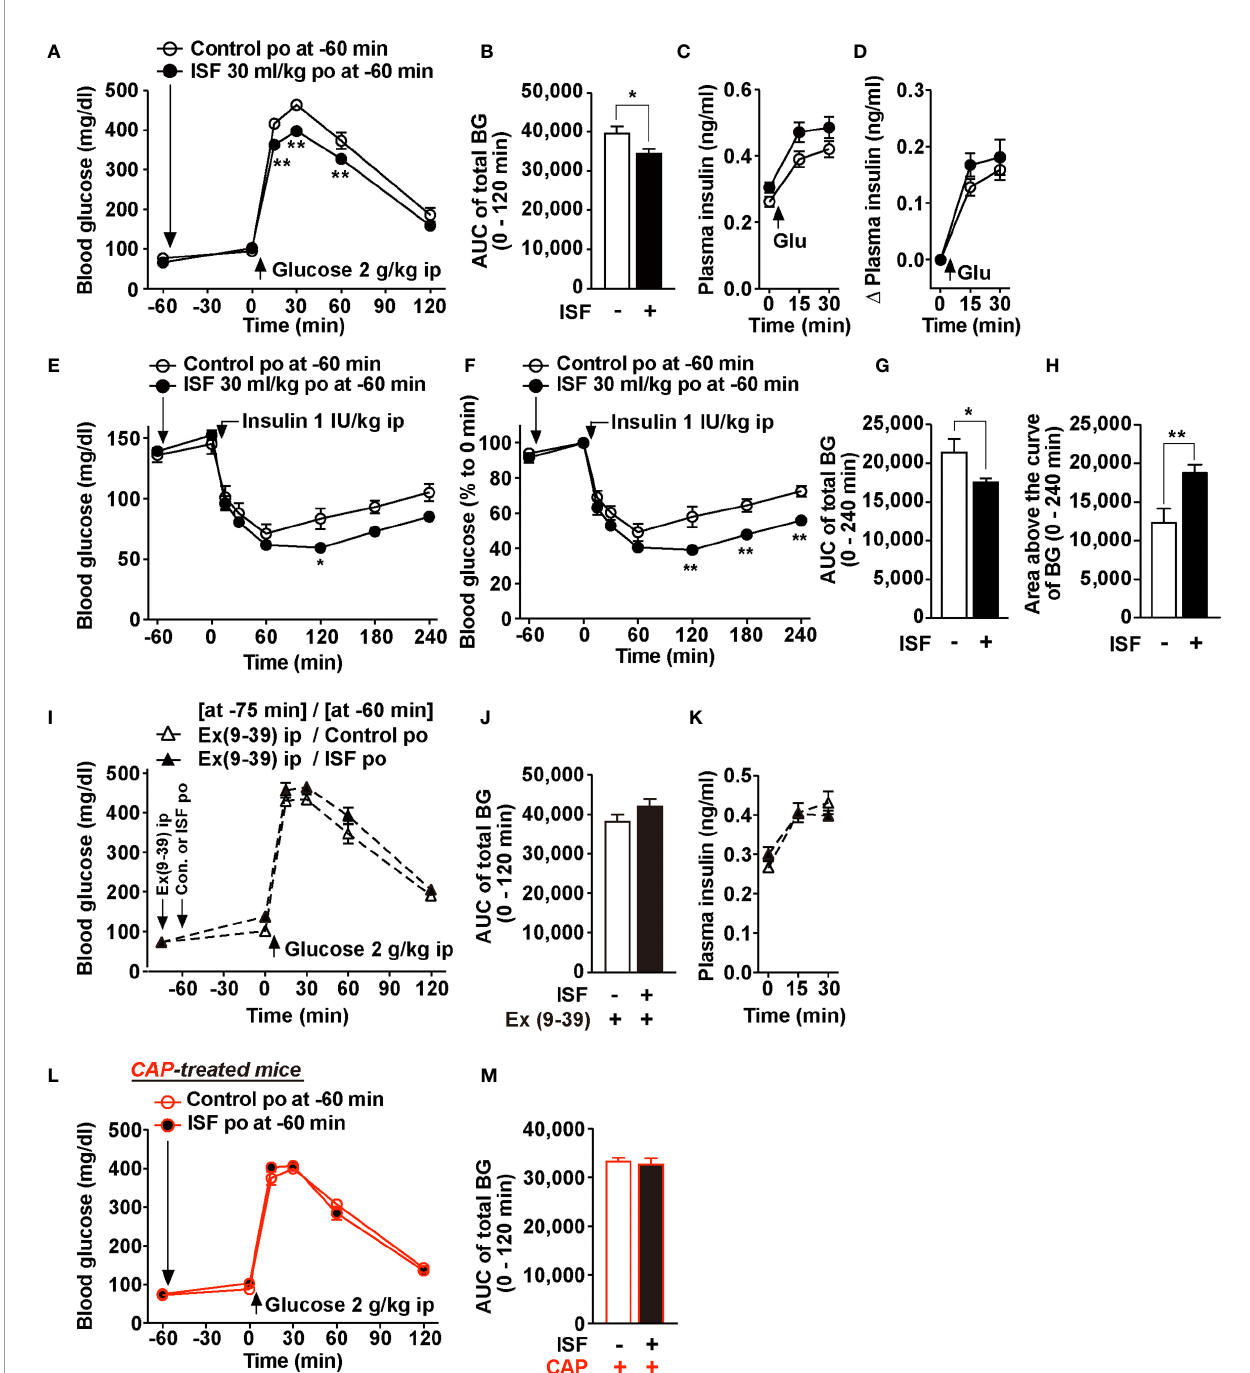
FIGURE 4 | ISF improves glucose tolerance via GLP-1R signaling and capsaicin-sensitive sensory nerves. (A – M) 30 ml/kg ISF was po administered at 60 min prior to ipGTT (2 g/kg, ip) or ITT (1 IU/kg, ip). (A – D) Blood glucose (A) and plasma insulin levels (C) before and after administration of glucose in mice fasted overnight (16 h). Area under the curve (AUC) of total blood glucose during 0 – 120 min in ipGTT (B) . Change ( D ) in plasma insulin levels after ipGTT plotted from (C, D) . n = 11. (E – H) Absolute value (E) and relative value (F) of blood glucose during 0 – 240 min in ITT in mice fasted for 4 h. AUC of total blood glucose in E (G) and area above the curve of blood glucose in E (H) . n = 5 – 6. (I – K) Exendin(9-39) amide [Ex(9-39)] at 600 nmol/kg was ip injected at 75 min prior to ipGTT. Ex(9-39) pretreatment blunted the action of ISF to attenuate rises of blood glucose (I) and its AUC (J) , and also did not affect plasma insulin levels (K) in ipGTT. n = 6. (L, M) Po ISF failed to improve glucose tolerance in CAP-treated mice fasted overnight (16 h). n = 7. ** p < 0.01 by two-way ANOVA followed by Bonferroni ’ s test vs. control (A, E, F) , and * p < 0.05 by unpaired t -test (B, G, H)